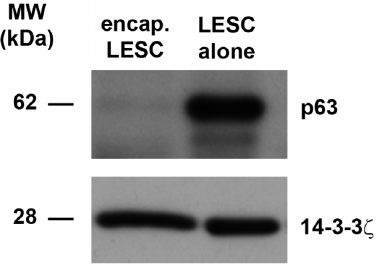
Figure 6. Cultured LESC retain a progenitor phenotype. P63 was detected in freshly isolated LESC (control: C), alginate-encapsulated LESC (Alg) and LESC cultured (Cult) in CnT20 for 3 days under cell culture conditions by immunoblotting. 14-3-3 f was used as a loading control. Blots represent 3 individual experiments from 3 different corneoscleral